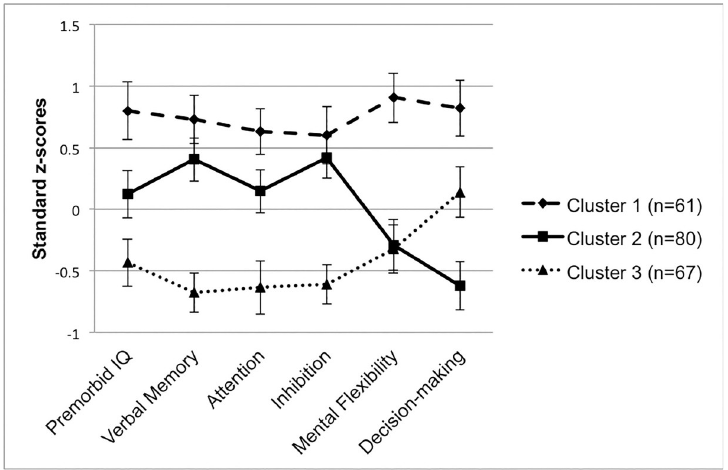
Fig 1. Neurocognitive profiles. Clusters plotted by mean neurocognitive score in standard z-score units based on sample mean and standard deviation. Error bars represent 95% confidence intervals.